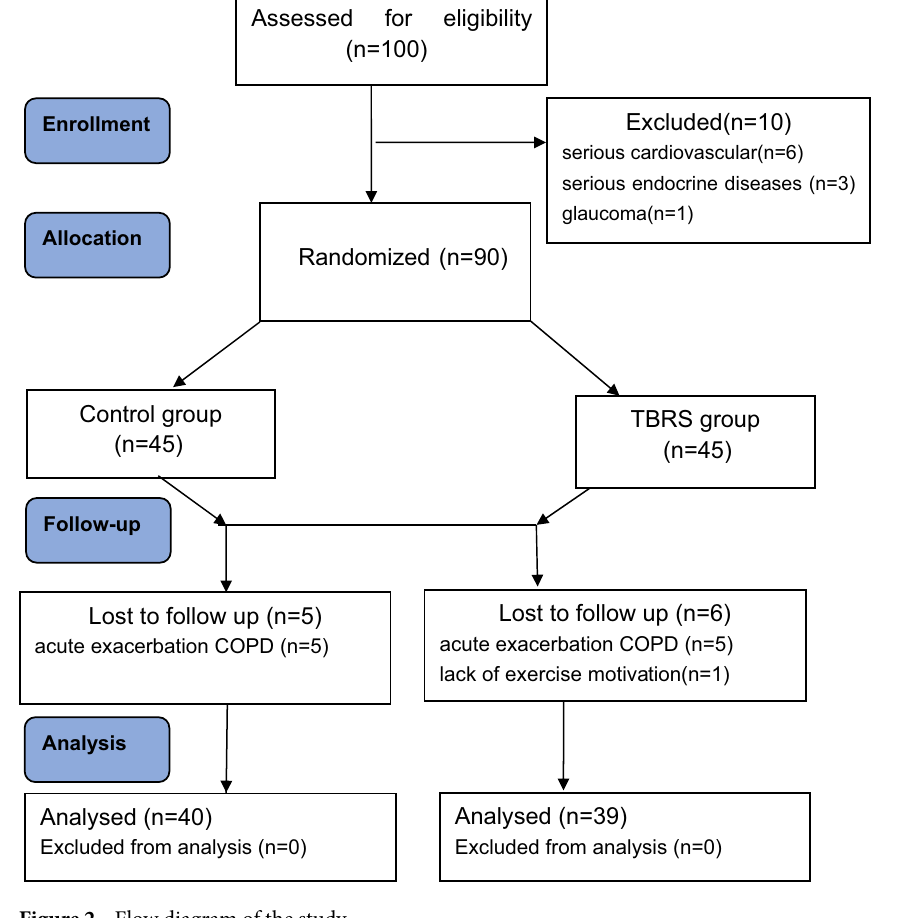
Figure 2. Flow diagram of the study.